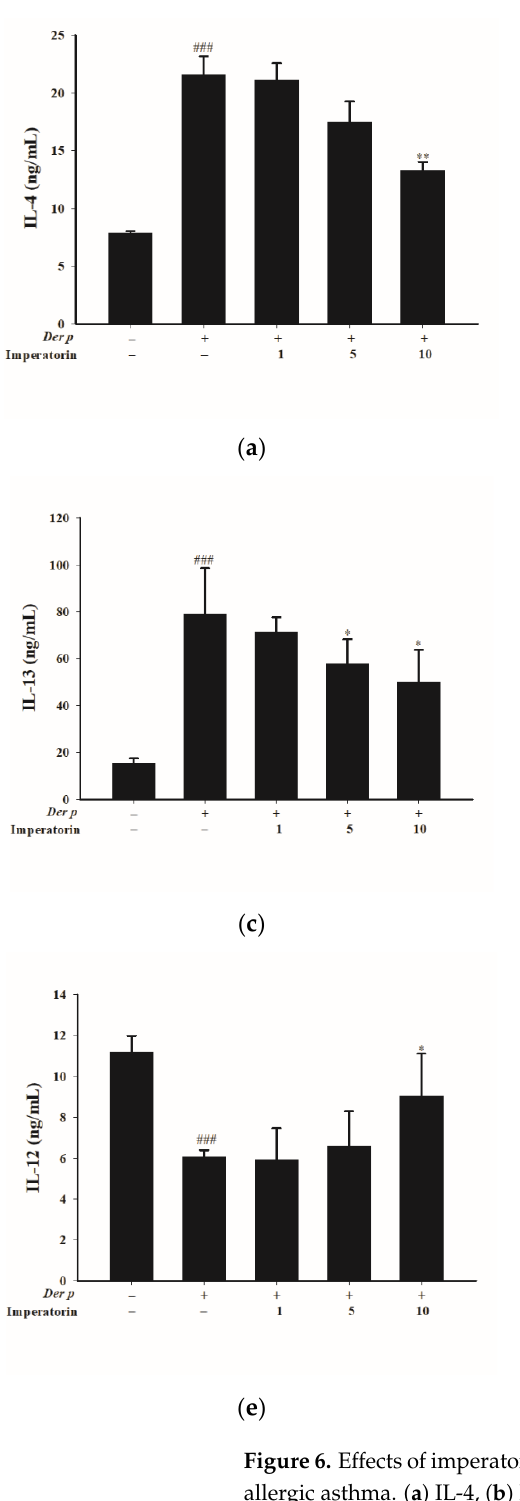
Figure 6f) concentrations increased with the imperatorin treatment.